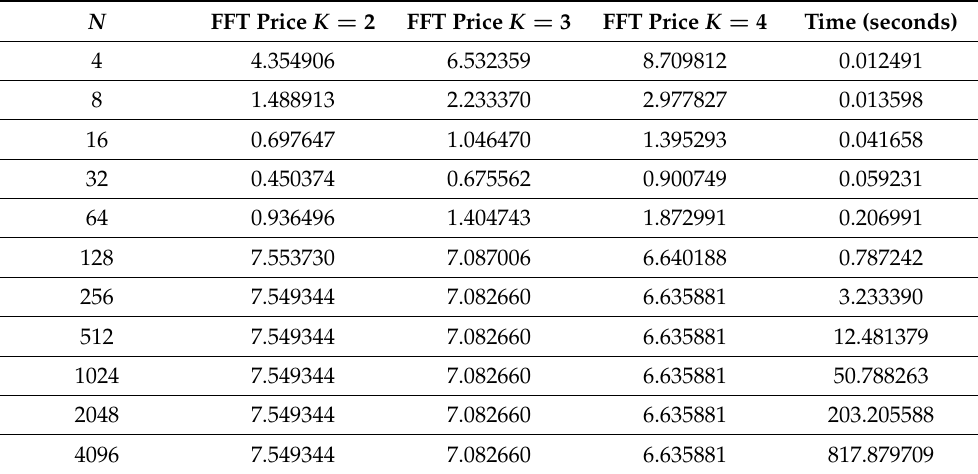
Table 2. Convergence of FFT using the parameters in Table